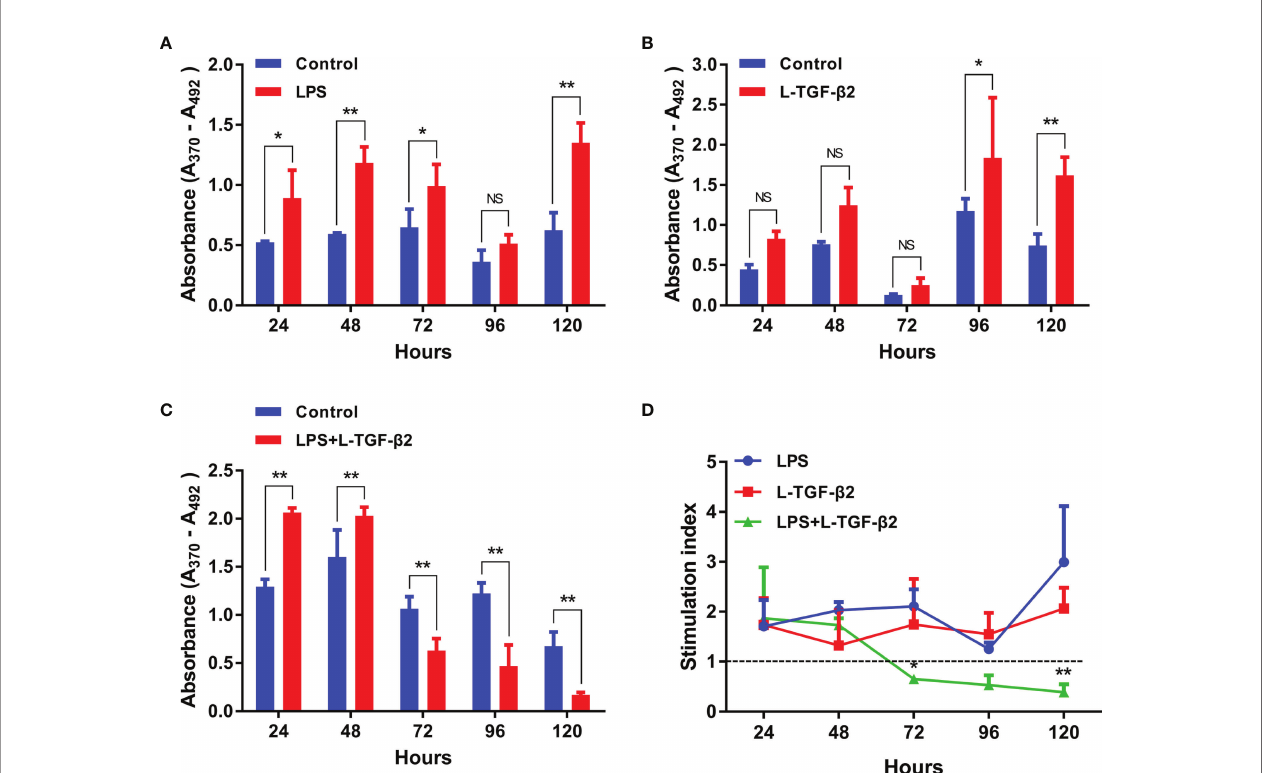
FIGURE 6 | The effect of rL-TGF- b 2 on the proliferation of quiescent and activated SMB cells in lampreys detected using the BrdU incorporation method. (A) The effect of LPS on the proliferation of SMB cells. The OD values are compared between the LPS-treated group with the control after 24, 48, 72, 96, and 120 h of incubation. (B) The effect of rL-TGF- b 2 on the proliferation of quiescent SMB cells. The OD values are compared between the rL-TGF- b 2-treated group with the control after 24 to 120 h of incubation. (C) The effect of rL-TGF- b 2 on the proliferation of LPS-stimulated SMB cells. The OD values are compared between the rL- TGF- b 2-treated group with the control after 24 to 120 h of incubation. In Figures (A – C) , the statistical analyses are all performed by multiple t -tests, in which the statistical signi fi cance is determined using the Holm-Sidak method, with alpha = 0.05. *: Adjusted p < 0.05, **: Adjusted p < 0.01, NS, Not signi fi cant. All experiments were repeated thrice. (D) Trends in the stimulation index of SMB cells proliferation under different treatment conditions. Two-way RM ANOVA is used for statistical analysis. Treatment condition: F (2, 6) = 17.56, P = 0.0031; Treatment time: F (4, 24) = 2.135, P = 0.1075; Interaction: F (8, 24) = 3.18, P = 0.0133. The LPS-treated group was subsequently set as the control for Dunnett ’ s multiple comparison test. LPS-treated group vs. LPS + rL-TGF- b 2 co-treated group: *: P = 0.0072 (72 h), **: P < 0.0001 (120